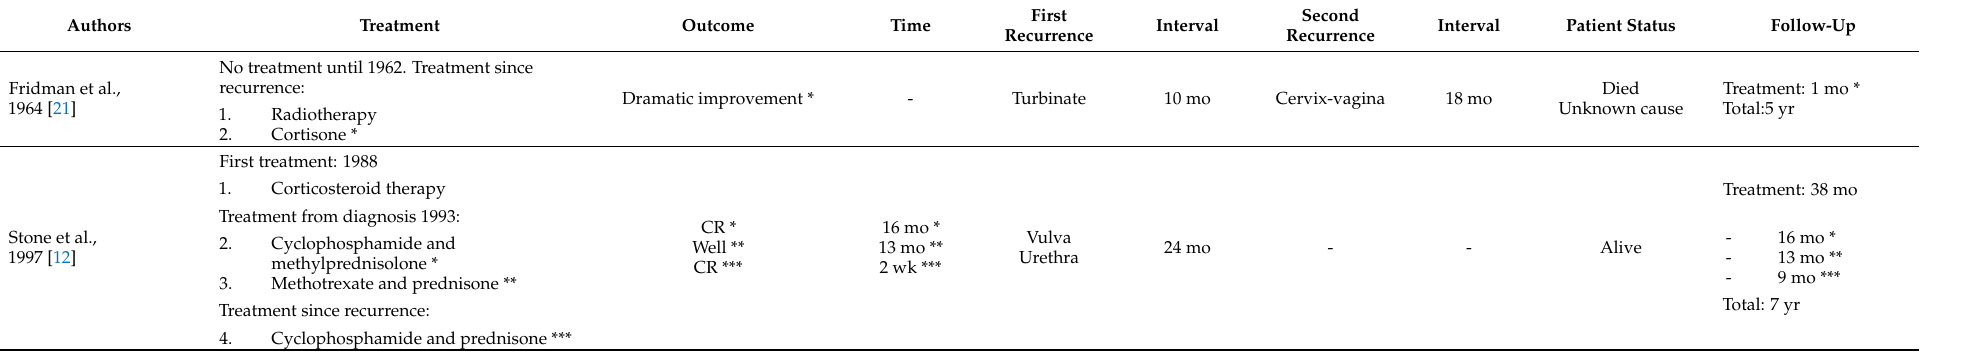
Table 4. Literature review of patients with previous history of GPA and gynecological